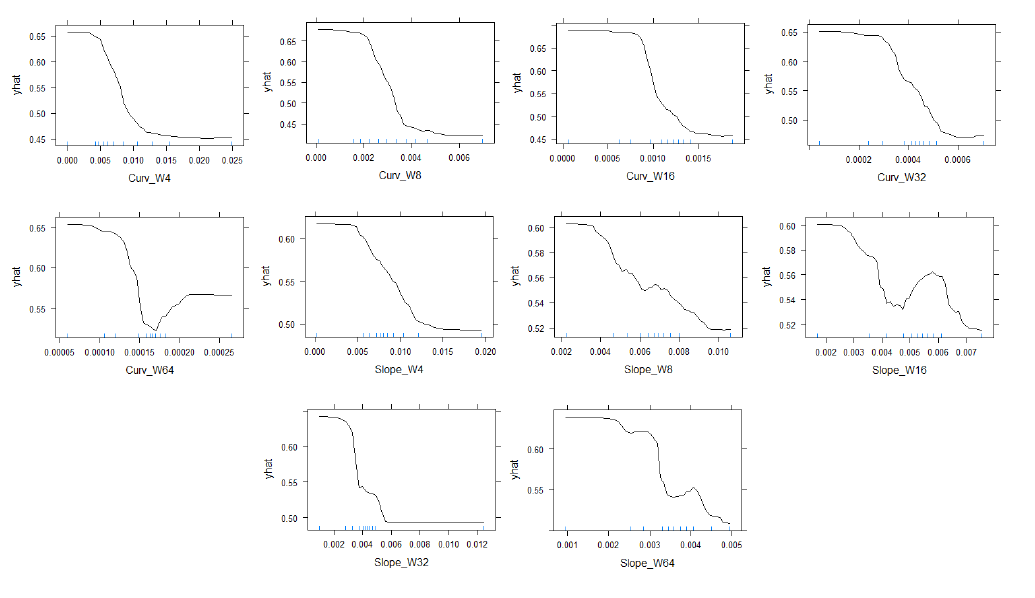
Figure 10. Partial dependence plots obtained for positive Curvature and Slope with NDVI for sliding window-based aggregation.